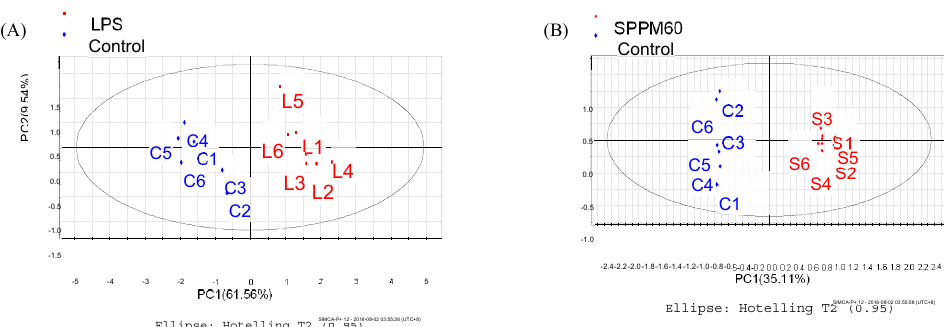
Figure 7. Orthogonal partial least Squares discriminant analysis OPLS-DA score plot of RAW264.7 cells from treatment and control groups. ( A ) LPS and control groups ( B ) SPPM60-Dand control groups.